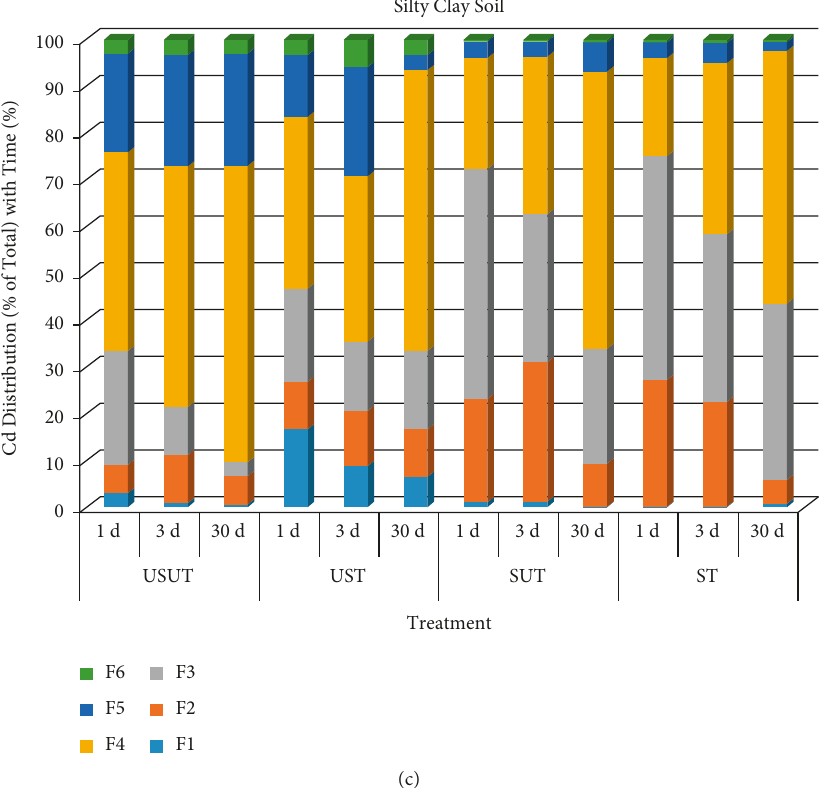
Figure 3: Speciation of cadmium into different fractions of three soils (a, b, c) in relation to time and different treatments; USUT- unspiked untreated, UST- unspiked treated with OM, SUT- spiked untreated with OM, ST- spiked treated with